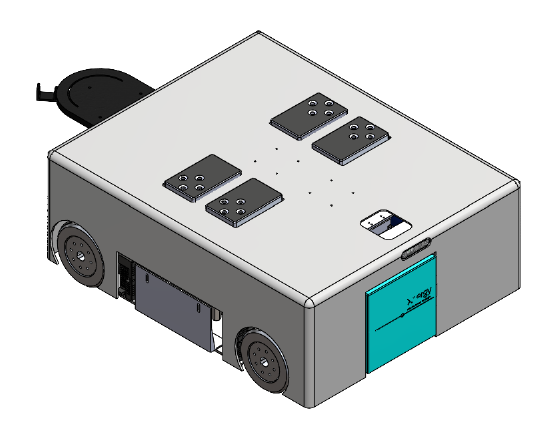
Figure 1. External view of Wasp platform.